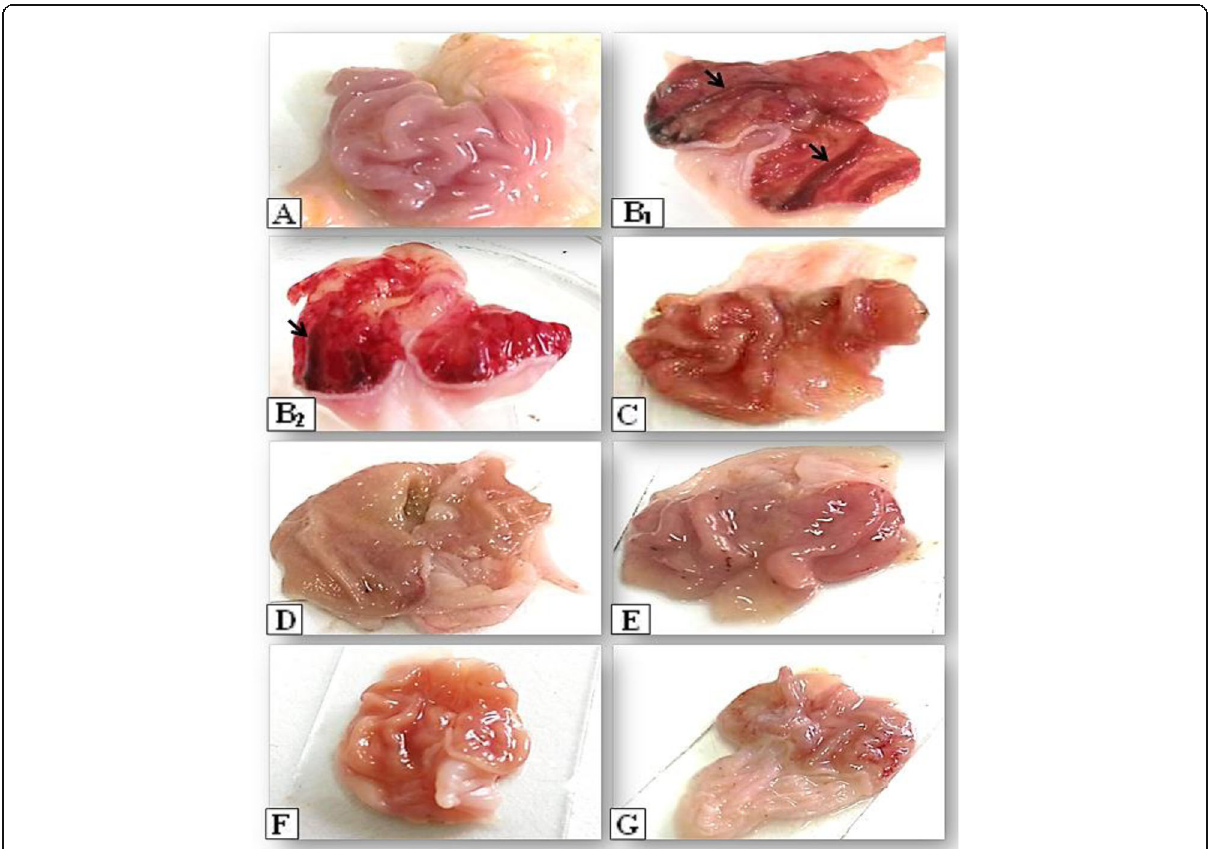
Fig. 6 Photograph of rat stomach showing protective effect of C. ignea aerial parts extract on the ethanol induced gastric ulceration in rat exposed to an experimental model as; Control ( a ), EtOH ( b ), Ranitidine ( c ), C. ignea 250 mg/kg ( d ), EtOH + C. ignea 250 mg/kg ( e ), C. ignea 500 mg/kg ( f ), EtOH + C. ignea 500 mg/kg ( g ). a showed normal intact gastric mucosa. b 1 and b 2 revealed severe dark red submucosal hemorrhagic strikes (black arrows). In ( c) congestion in gastric mucosa appeared. In ( d and f ) the gastric mucosa exhibited normal gross appearance with slight hyperemia and normal thickening in mucosa. In ( e and g ) the gastric mucosa returned back to normal gross appearance with no lesions